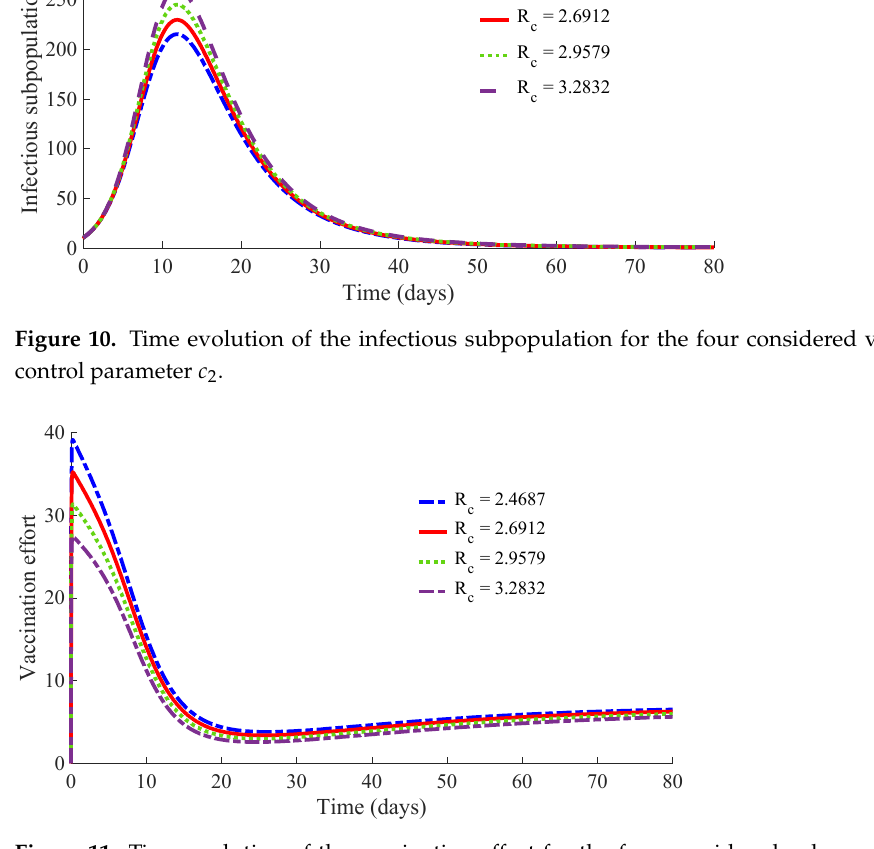
Figure 11. Time evolution of the vaccination effort for the four considered values of the control parameter c 2